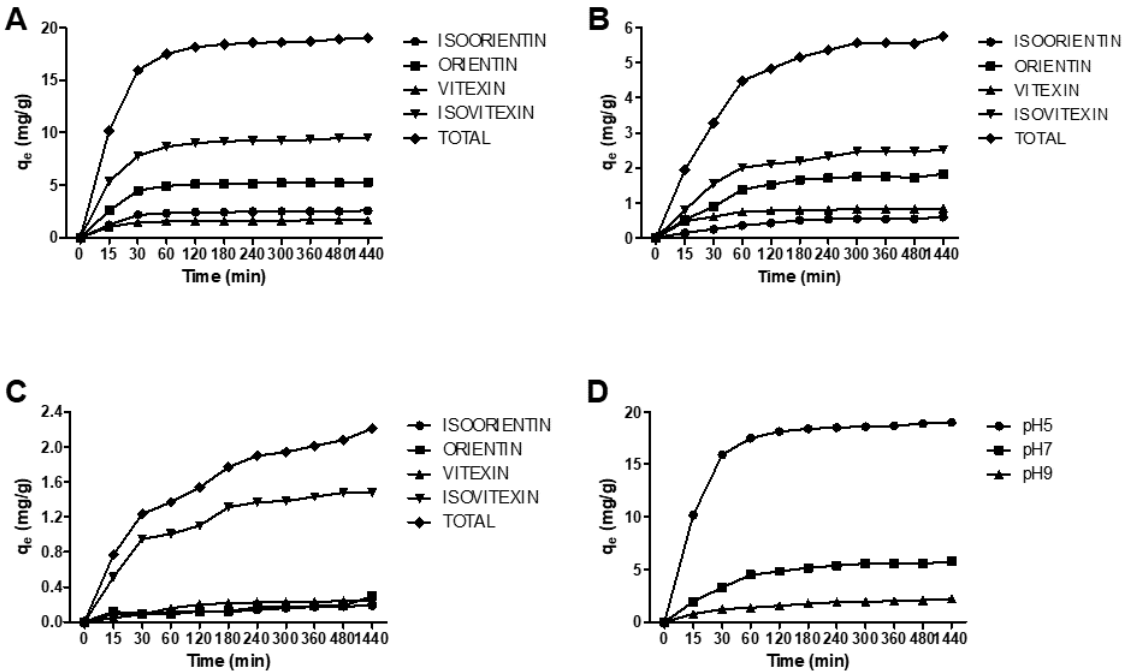
Figure 4. Adsorption kinetic curves of C -glycosyl flavonoids on the XAD7HP resin at pH levels of 5 ( A ), 7 ( B ), and 9 ( C ), and the total of four C -glycosyl flavonoids present in the OPLAH at different pH levels ( D ). Each value is the average reading from three replicates (n = 3).